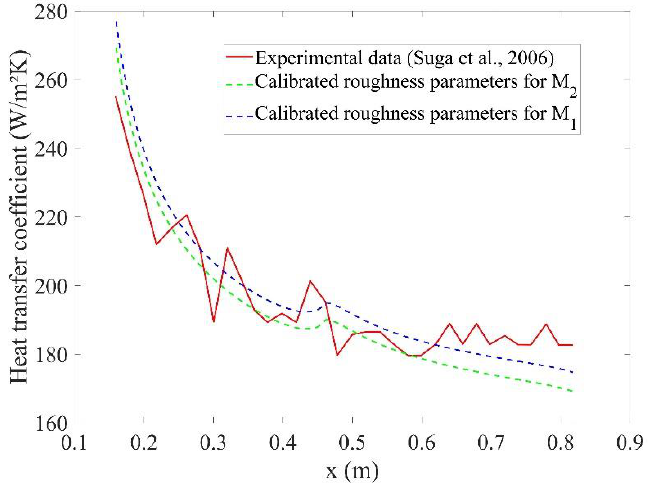
Figure 9. Heat transfer coefficient after Bayesian calibration.